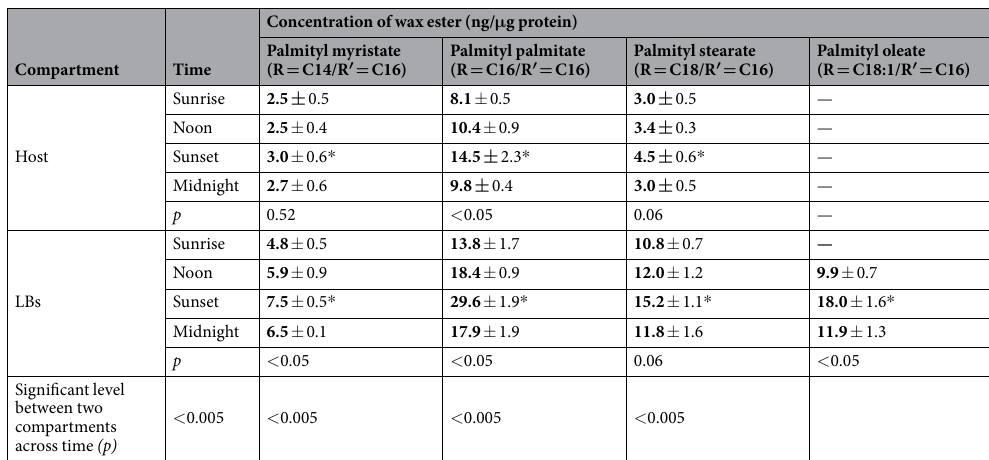
Table 1. Wax esters (WEs) concentrations in host coral gastrodermal cells and lipid bodies (LBs) across the diel cycle. Data were analyzed with multi-factor ANOVA to determine the effect of cellular compartment (host vs. LBs) and time for each WEs species ( * p < 0.05, ** p < 0.005, *** p < 0.001), and letters adjacent to values (concentration ± SD) represent statistically significant differences across sampling times and compartment within a WE species, as determined by Tukey’s post hoc tests ( p < 0.05). The concentrations of all four lipid species were higher in LBs than host gastrodermal cells at all four sampling times ( p < 0.05; excepting C18:1/R ′ = C16 at sunrise), as well as when data were pooled over time for each of the four lipid species ( p < 0.05). “—” = not